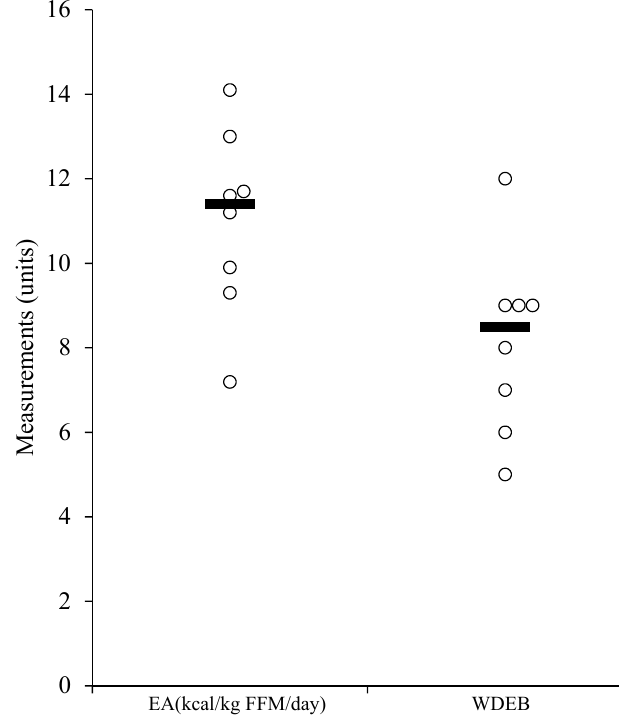
Figure 2. Univariate scatter plots for energy availability (EA) and WDEB − 300.